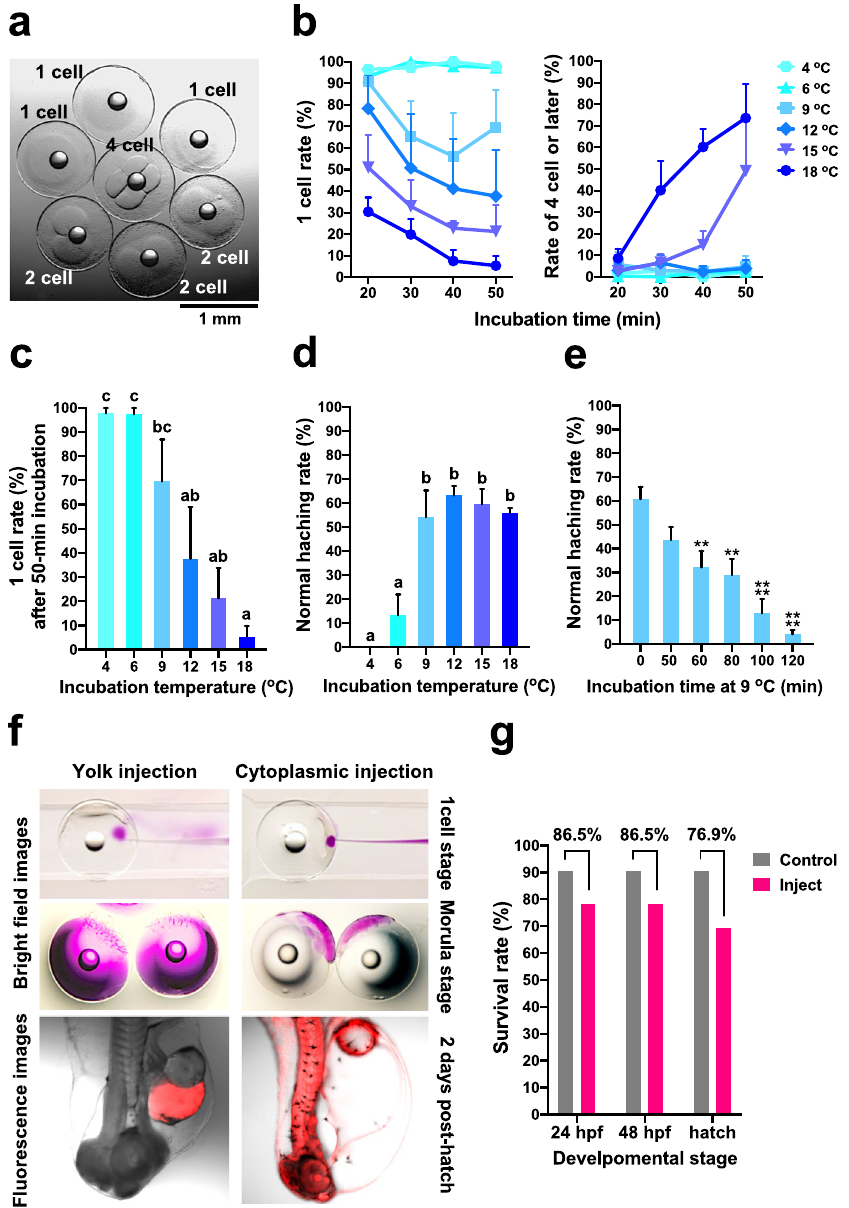
Figure 2. Microinjection into chub mackerel embryos. ( a ) Cleavage of fertilized eggs of chub mackerel. ( b ) Percentage of 1-cell stage eggs at each time (left) and percentage of eggs that reached the 4-cell stage or later (right) when the collected fertilized eggs were incubated in seawater at various temperatures (n = 3). ( c ) Percentage of 1-cell stage eggs when the collected fertilized eggs were placed in seawater at various temperatures for 50 min. Different letters above the bars represent significant differences (P < 0.05) in data across various incubation temperatures. ( d ) Normal hatching rate, when the collected fertilized eggs were placed in seawater at various temperatures for 50 min and then returned to the natural seawater temperature of 18 °C for incubation. Different letters above the bars represent significant differences (P < 0.05) in data across various incubation temperatures. ( e ) Normal hatching rate, when the collected fertilized eggs were placed in seawater at 9 °C for various durations from 50 to 120 min and then returned to the natural seawater temperature of 18 °C for incubation. Asterisks indicate a significant difference when compared to the control group. **P < 0.01, ****P < 0.0001. ( c – e ) Data are expressed as the mean ± SEM (n = 3) and analyzed by one-way ANOVA followed by a Turkey’s multiple comparison test. ( f ) Localization of the dye at each stage of development when the fluorescent dye (200 mM KCl solution containing 0.05% Dextran, Rhodamine B) was microinjected into the yolk or cytoplasm. ( g ) Embryo survival and normal hatchability after 24 and 48 h of microinjection into the